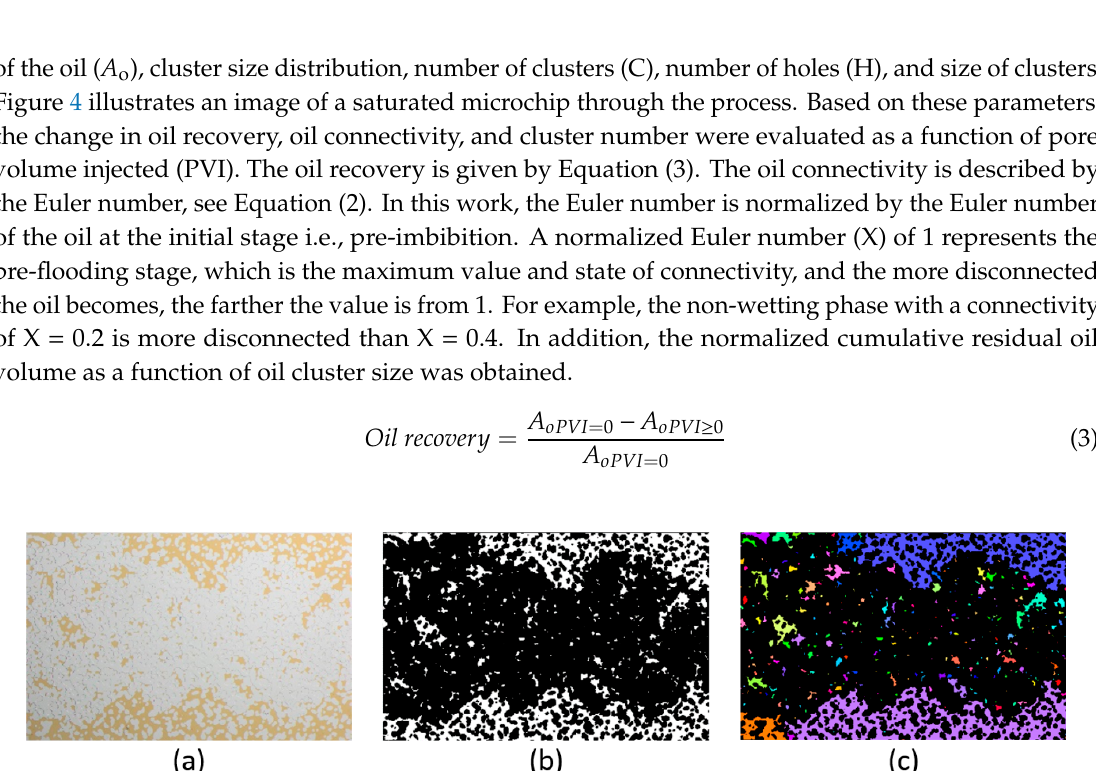
Table 7. Interfacial tension (IFT) and contact angle values. Each experiment lasted for 12 h. The average value from the last hour of the experiment is reported in the table. Measurements were made at ambient conditions. Fluid